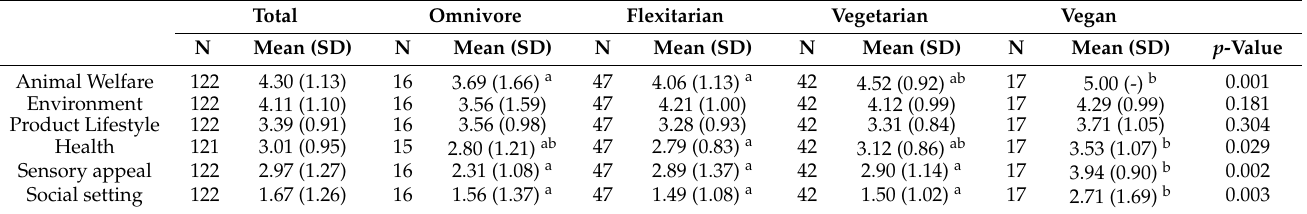
Table 8. Motives for purchasing PBCAs 1 by diet measured on a 5-point-scale (1 “totally disagree”, 5 “totally agree”).